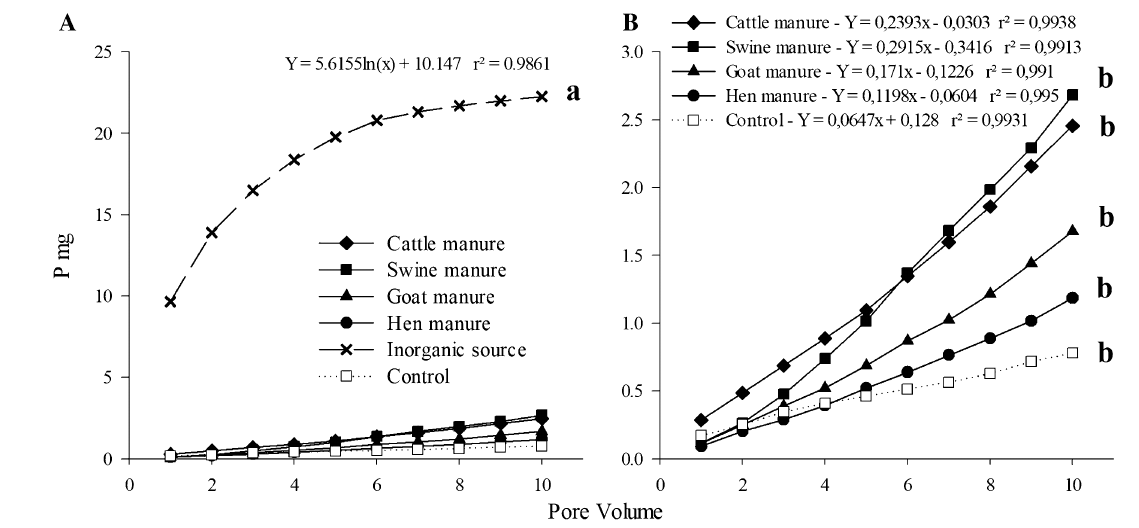
Fig. 2 Leaching of P (mg) for different sources in Dystric Xeropsam- ments in 20-cm columns depending on the volume of pores. a P (mg) in all treatments; b the same a with cut in the “ y ”-axis at 3 mg of P.